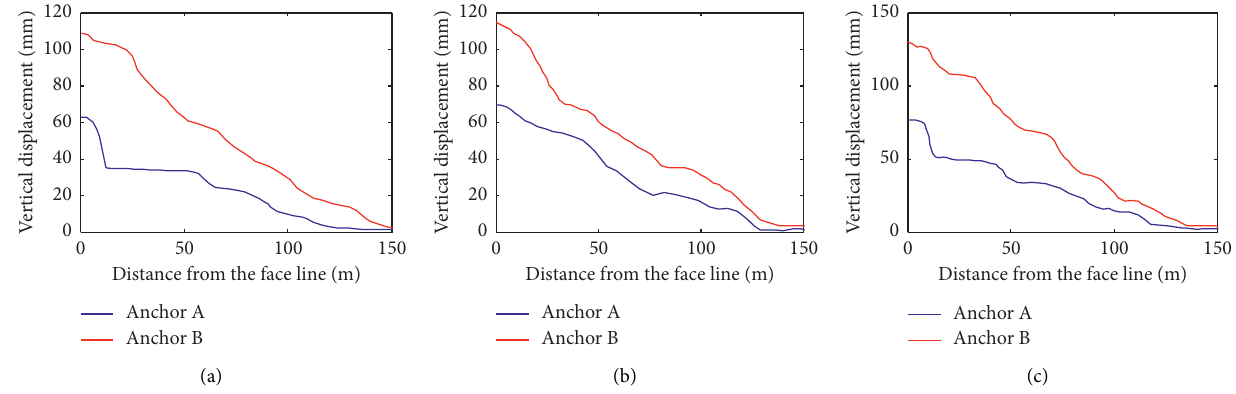
Figure 5: Vertical displacement of roof strata. (a) 1# station. (b) 2# station. (c) 3# station.